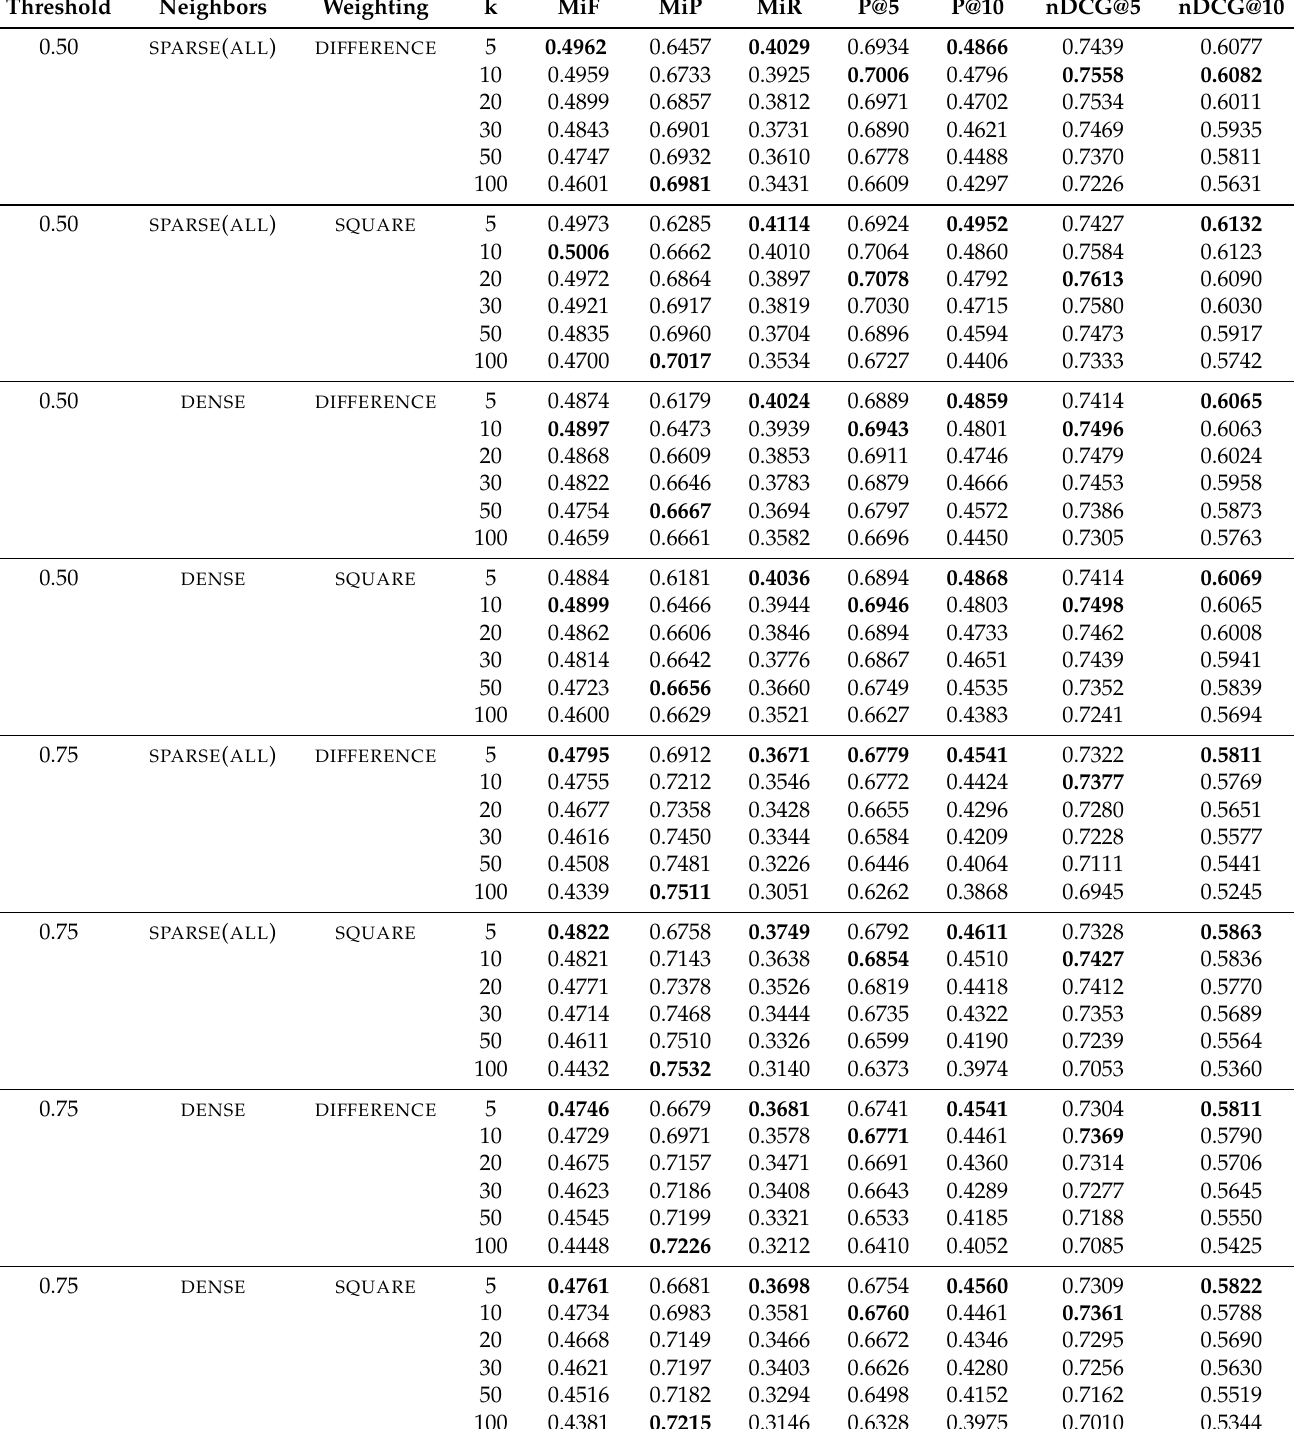
Table 7. Performance with LARGE label-AE